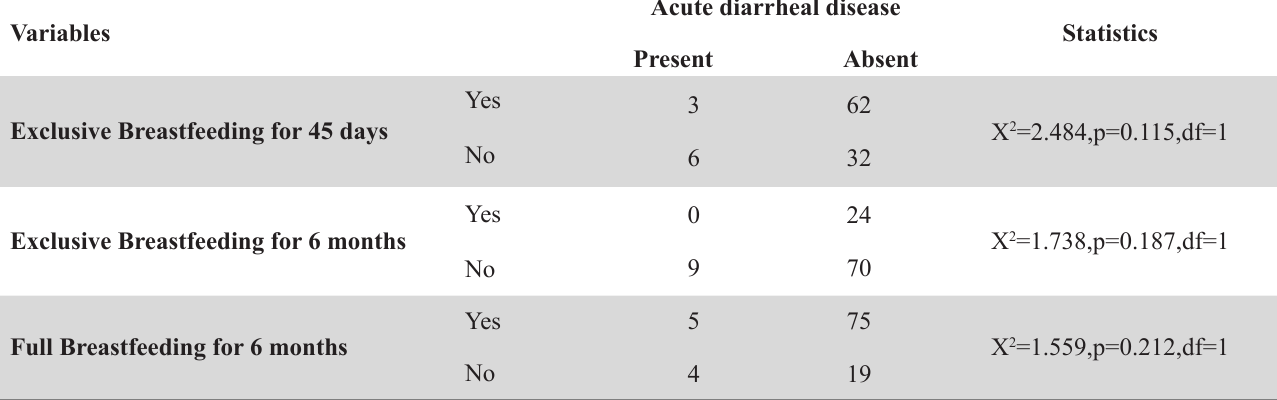
Table 3: Incidence of acute diarrheal episodes in differently breastfed